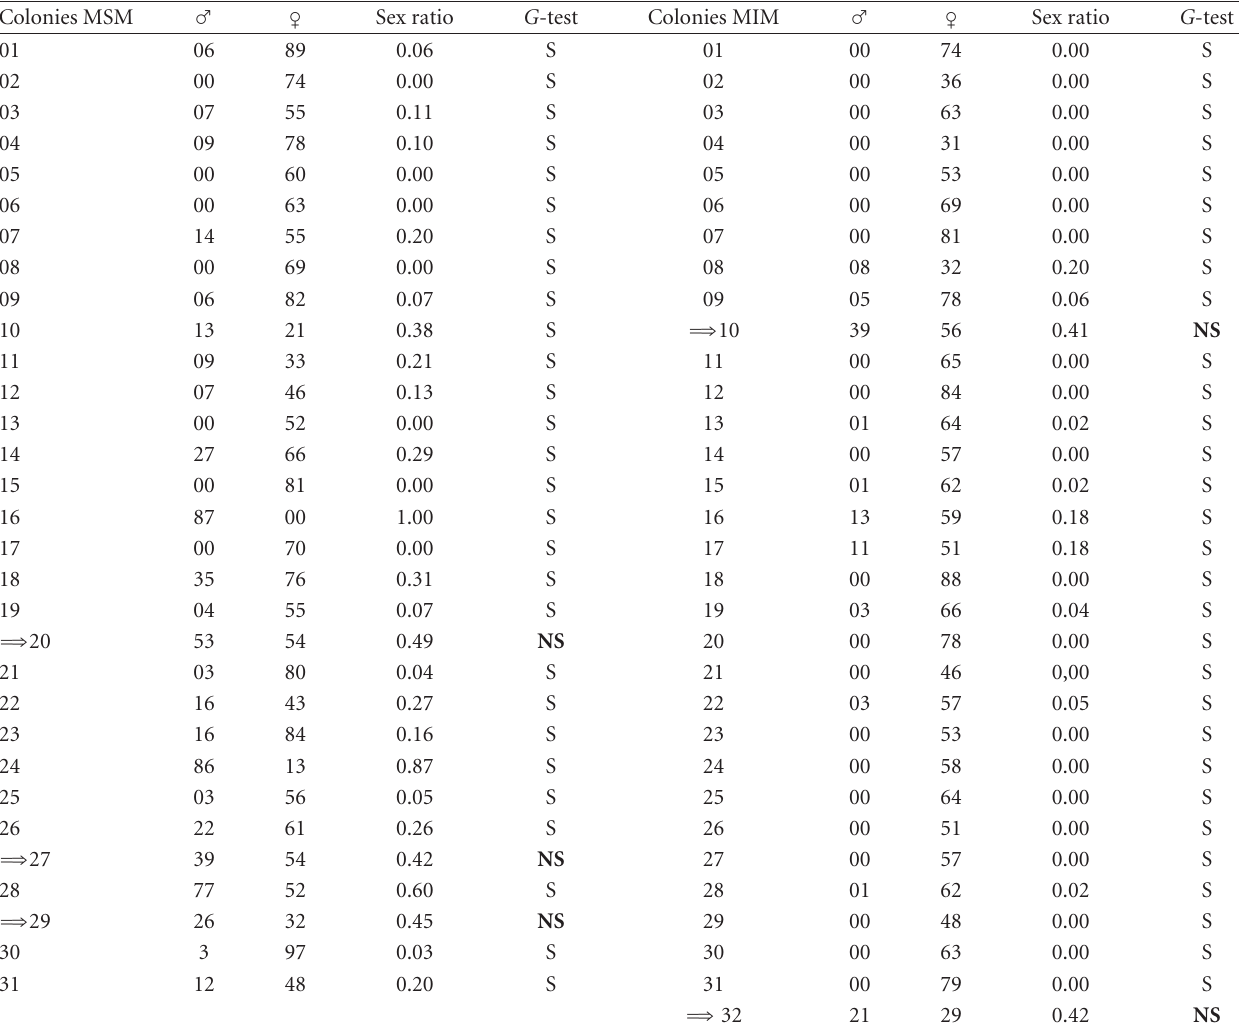
Table 1: Sex segregation of Melipona seminigra merrillae (colonies MSM) and M. interrupta manaosensis (colonies